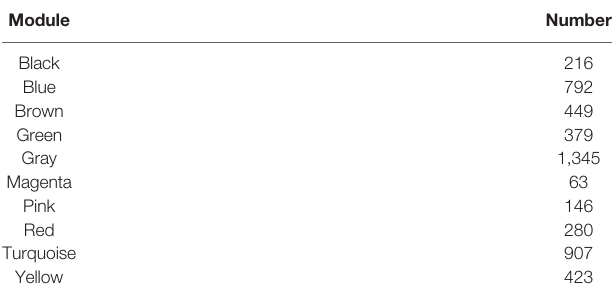
TABLE 2 | Gene numbers of each module in